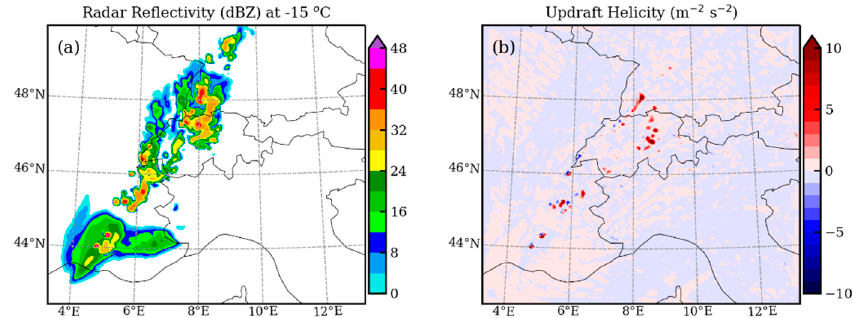
Figure 13. Simulated radar reflectivity ( a ) at − 15 °C and the updraft helicity ( b ) at 2 UTC on 29 July 2013. The upward helicity was calculated by the routine “udhel” in the wrf-python processing tool based on [89].